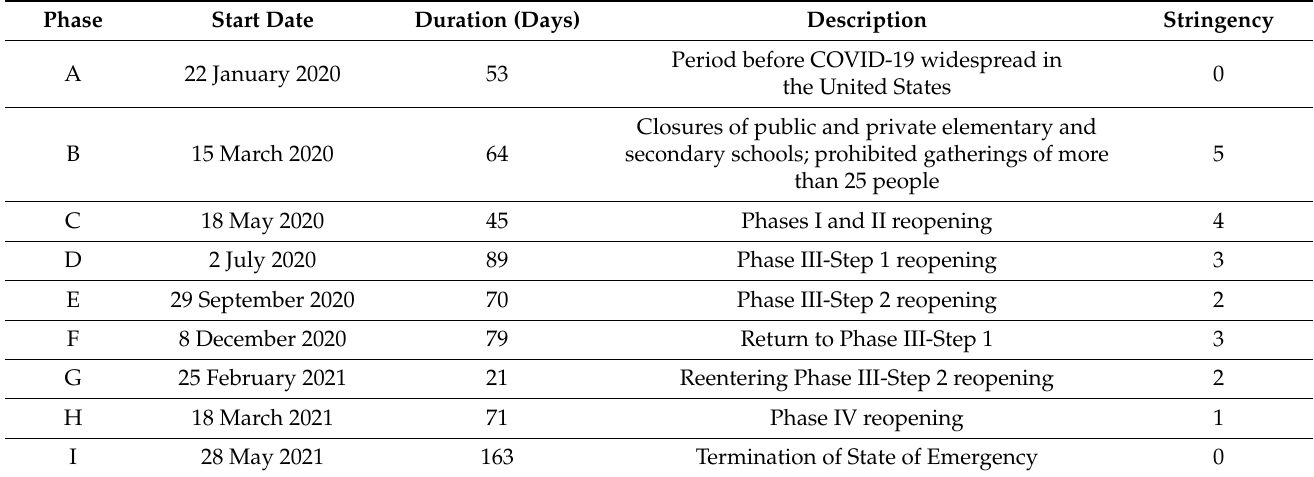
Table 1. Non-pharmaceutical intervention phases in accordance with Massachusetts statewide COVID-19 health advisories. We defined intervention phases according to the Massachusetts shel- ter in place order on 15 March 2020 and subsequent reopening of businesses and public venues thereafter [52]. We assigned a stringency score for each phase where 5 reflects the most stringent mandates to reduce social mobility and disease transmission while 0 reflects periods before and after the statewide state of emergency. We report the duration of each phase in days. Phase I du- ration is reported from the termination of the state of emergency to the end of our study period (7 November